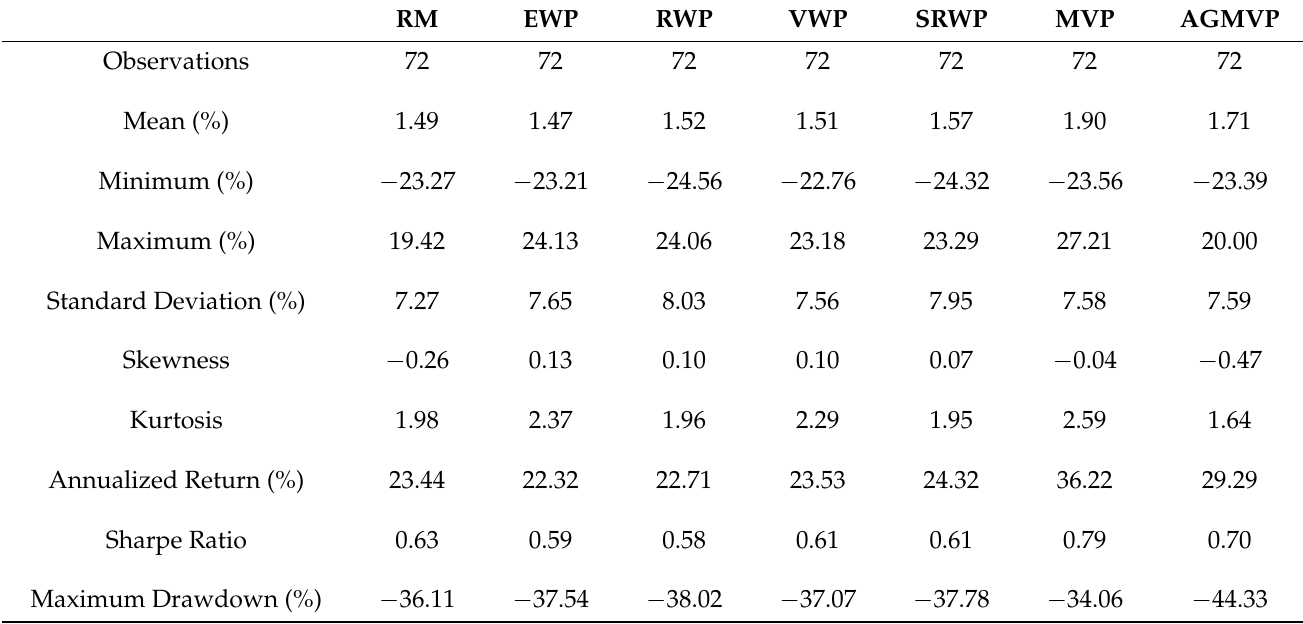
Table 12. Sector portfolios of MSCI China